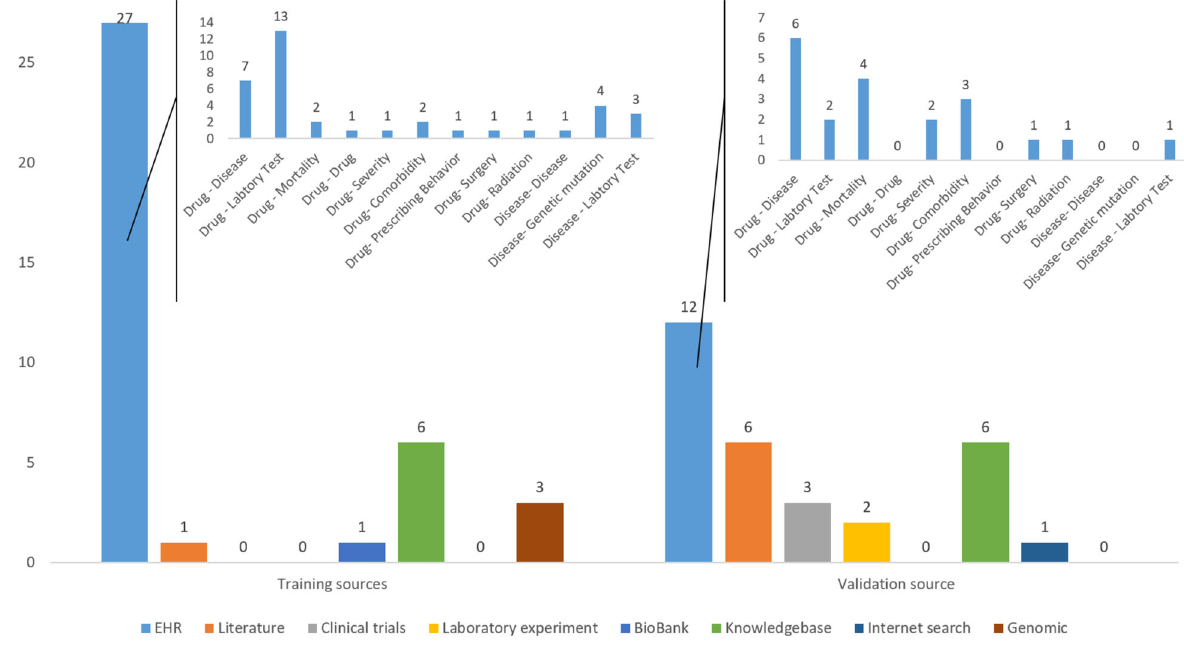
Fig. 4 Distribution of resources for training and validation.